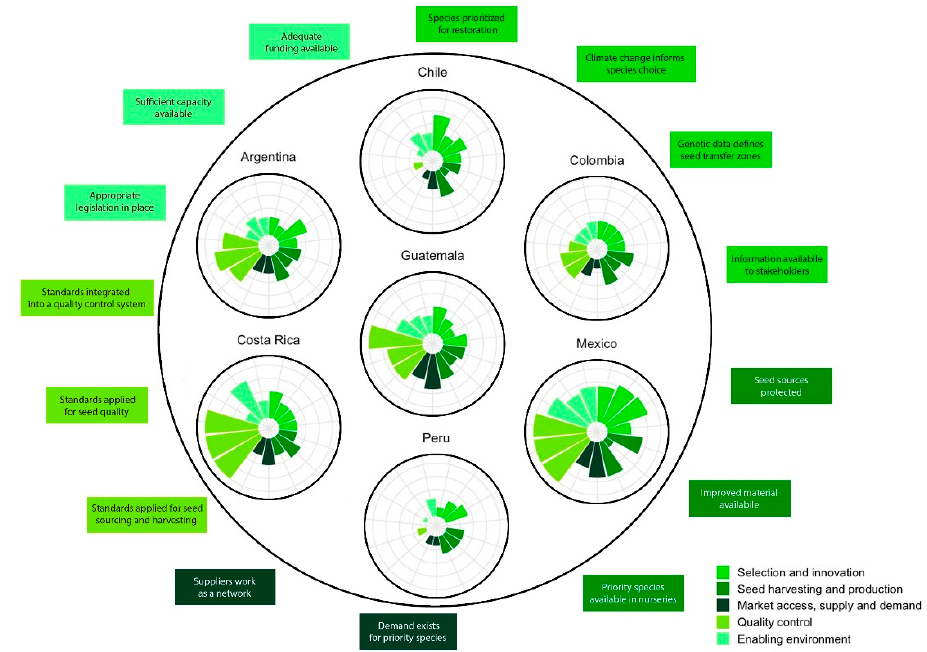
Figure 1. Radar charts illustrating the scores assigned to the 15 indicators for each of the 7 countries analyzed (Argentina, Chile, Colombia, Costa Rica, Guatemala, Mexico, Peru). The results are color- coded by the 5 components (selection and innovation, seed harvesting and production, market access, supply and demand, quality control, and enabling environment .